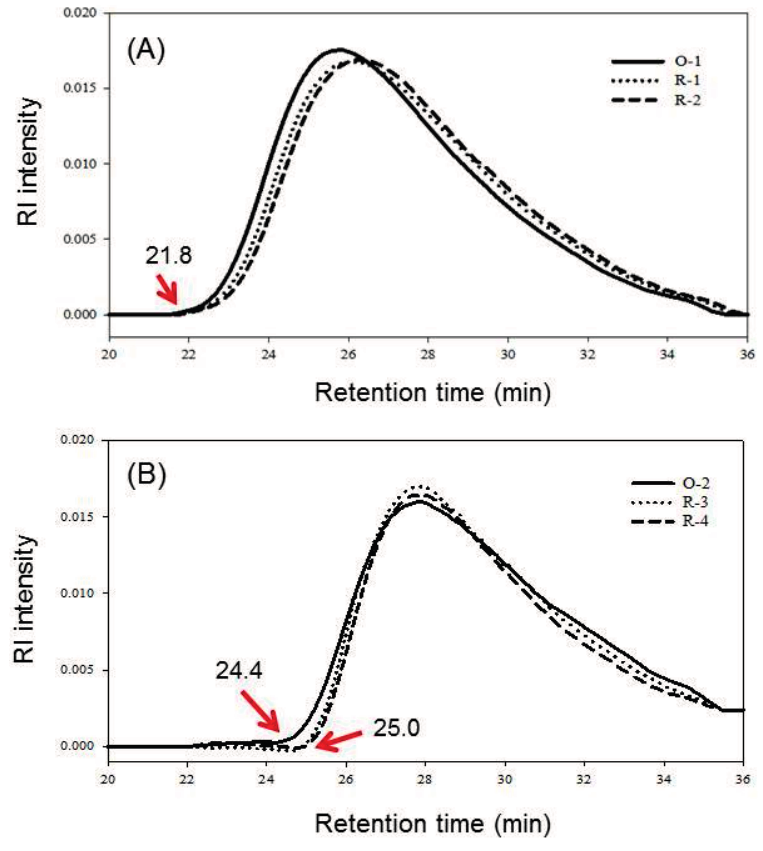
Figure 1. The SE-HPLC elution patterns of chitosans and regenerated chitosans. ( A ) 61.7% DD chitosan; ( B ) 94.9% DD chitosan. Samples O-1, R-1, R-2, O-2, R-3, and R-4, respectively, are described in Table